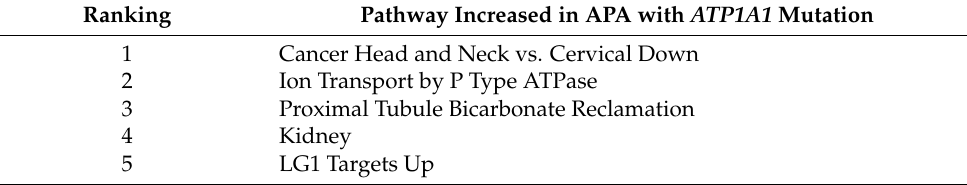
Table 1. Pathway analysis using Gene Set Enrichment Analysis (GSEA) of genes expressed in five aldosterone-producing adenomas (APA) with an ATP1A1 mutation and five non-functioning adrenocortical adenomas (NFA). Ranking Pathway Increased in APA with ATP1A1 Mutation 1 Cancer Head and Neck vs. Cervical Down